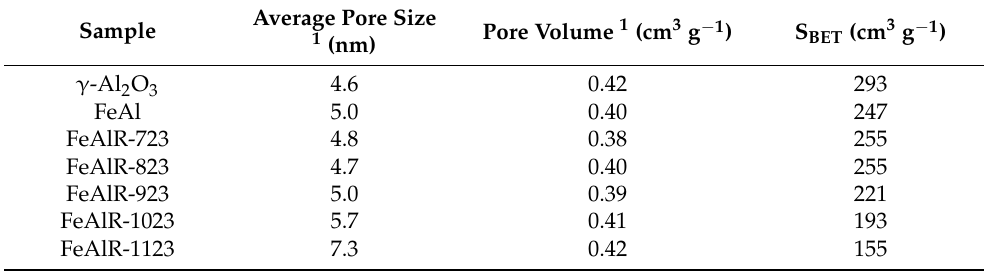
Table 1. Textural properties of γ -Al2O3 spheres and pre-synthetic hybrid samples.